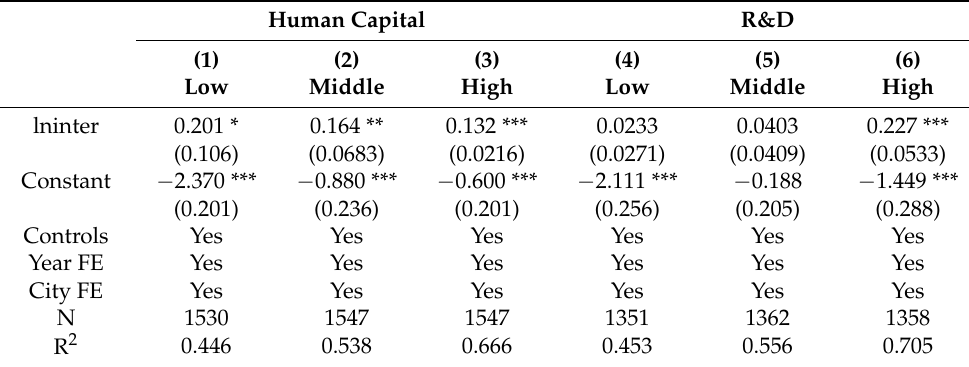
Table 10. The impact of absorptive capacity. Human